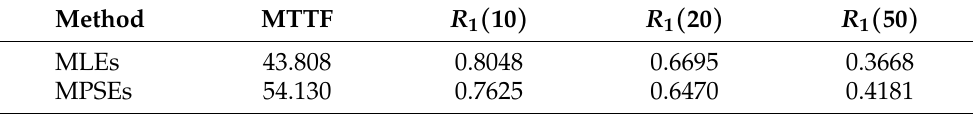
Table 7. The MLEs and MPSEs of the MTTF and RF for the oil breakdown Type-II censored CSPALT data.